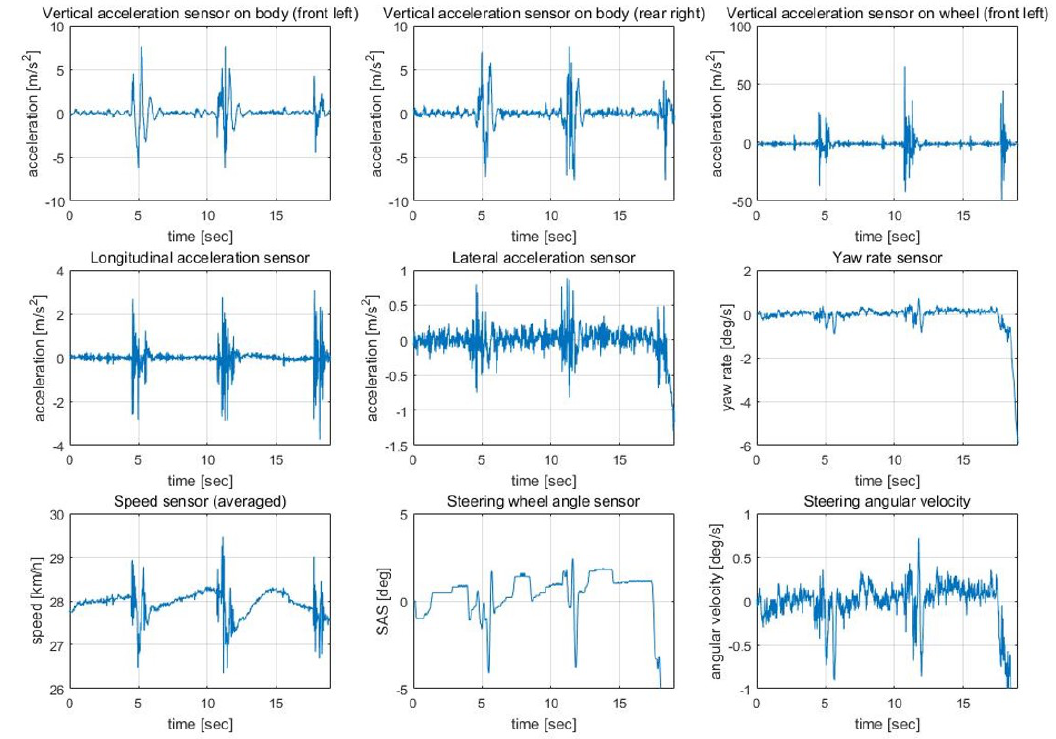
Figure A2. Sensor data on bump road, 30